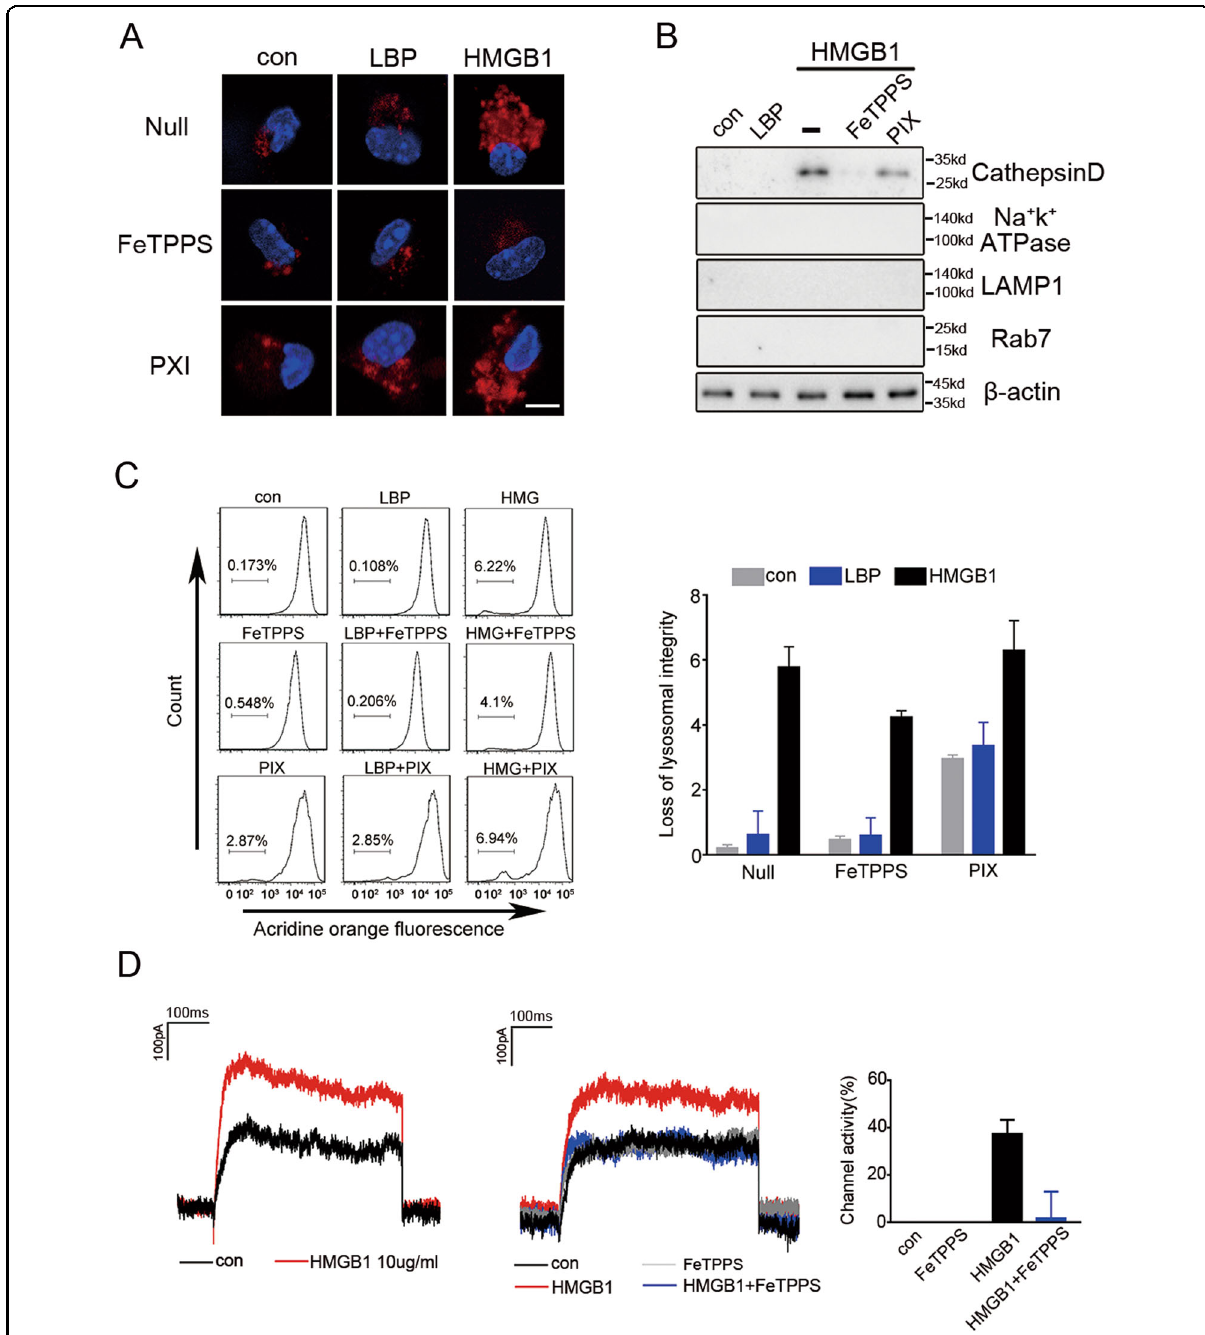
Fig. 6 FeTPPS inhibits the cytosolic delivery of LPS through preventing HMGB1-induced lysosomal rupture. A Confocal microscopy of mouse peritoneal macrophages incubated for 4 h with DQ ovalbumin (10 μ g/mL; red) alone or together with LPS-binding protein (10 μ g/mL), or together with HMGB1(10 μ g/mL) in the absence or presence of FeTPPS (1 μ M) or PIX (1 μ M) for 4 h, then stained with DAPI (blue). Scale bar: 10 μ m. B Western blots for cathepsin D, Na + -K + -ATPase, Lamp1, Rab7 in the cytosolic fraction from vehicle-treated or LBP (5 μ g/mL) or HMGB1 (5 μ g/mL) with or without FeTPPS(1 μ M) or PIX (1 μ M)-treated mouse peritoneal macrophages. C Flow cytometry of mouse peritoneal macrophages stained with acridine orange and then treated for 4 h with LBP (10 μ g/mL) or HMGB1 (10 μ g/mL) with or without FeTPPS (1 μ M) Numbers above bracketed lines indicate percent cells with loss of lysosomal staining with acridine orange (excitation, 488 nm; emission, 650 – 690 nm). D Whole-cell patch-clamp recording of HMGB1 in the absence or presence of FeTPPS (1 μ M) induced inward current across the cytoplasmic membrane in proximity to the patch-clamp of HEK293 cells at acidic conditions (pH = 5.0). Graphs show the mean ± SD of technical replicates and are representative of at least three independent